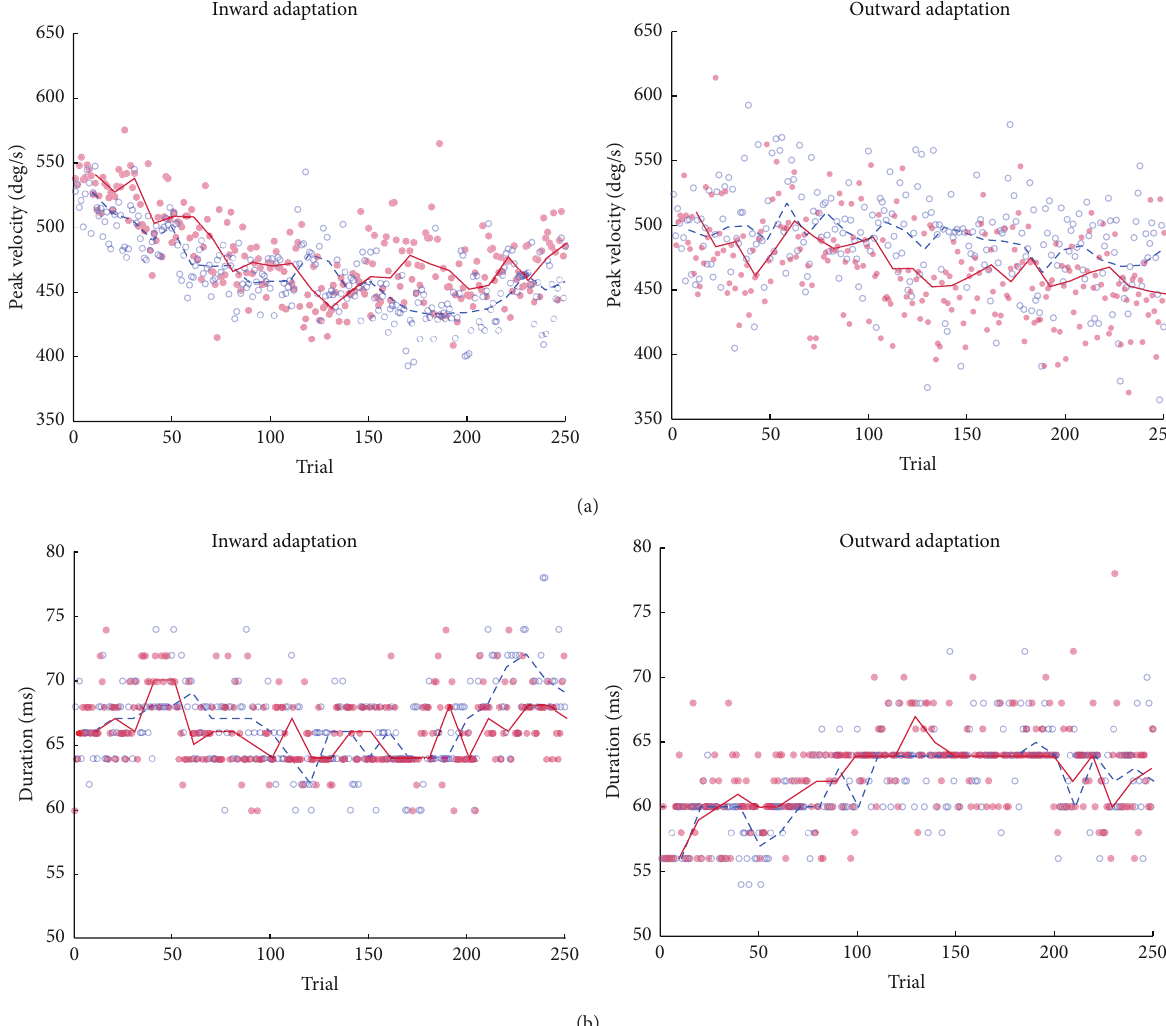
Figure 3: Saccade kinematics for sham and tDCS conditions. Left panel shows inward adaptation experiment and right outward adaptation experiment. (a) Peak velocity evolution throughout the trials as median values for all the subjects. Line on the top depicts blocks composed of the median values of 10 trials. For inward adaptation (left) a clear reduction of the velocity is observed as gains become smaller, not present in the same way for the increasing gains in outward adaptation (right). (b) Saccade durations as median values for all subjects. Line on the top depicts blocks composed of the median values of 10 trials. On the left, saccade durations become slightly smaller as gains become smaller. On the right, saccade durations increase as the task evolves as a result of saccade